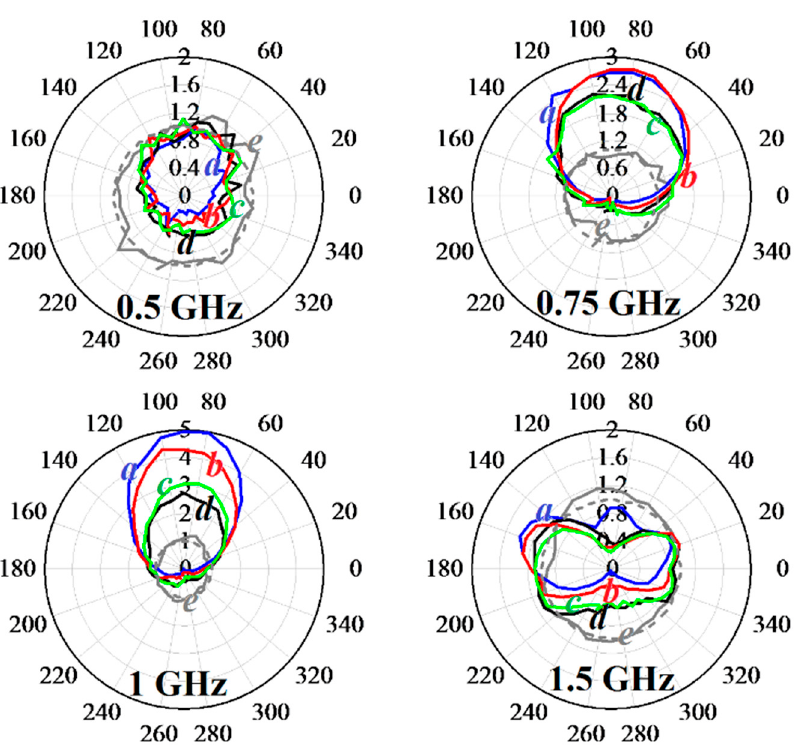
Figure 5. Radiation patterns for the second lamp configuration at different frequencies and discharge currents. The curve designations ( a – e ) correspond to those in Figure 4. Table 2. Antenna system directivity (dB) for the second lamp configuration.